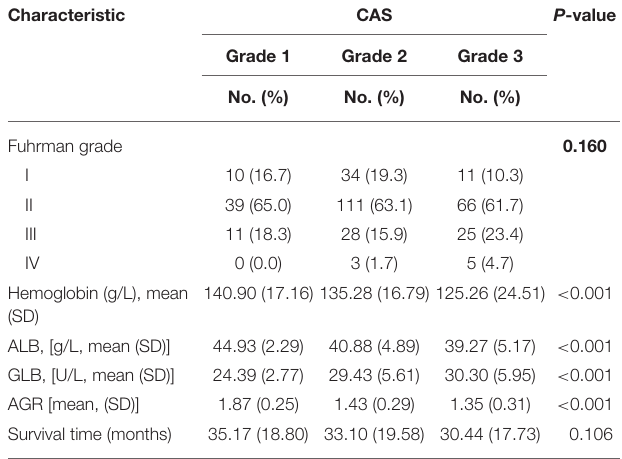
TABLE 3 | Comparison between CAS and clinic pathological characteristics in training